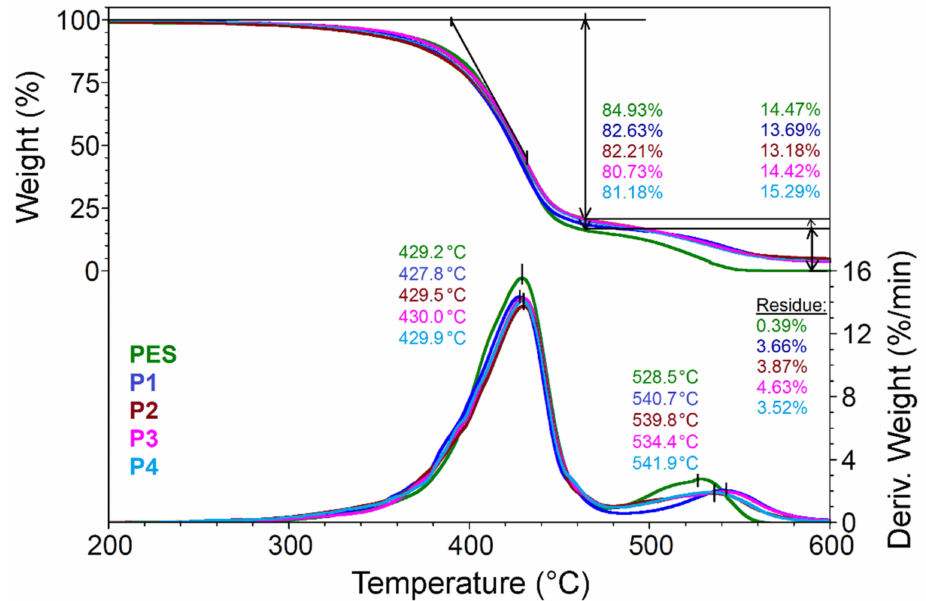
Figure 7. Thermogravimetric curves of hybrid